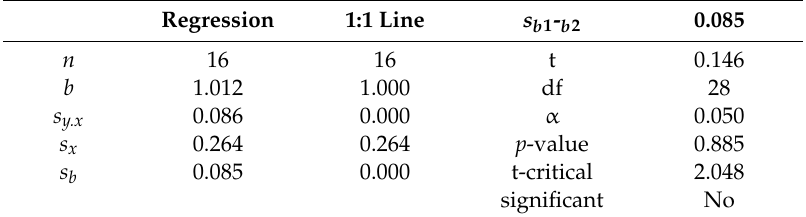
Table A1. Comparison of regression line and 1:1 line.